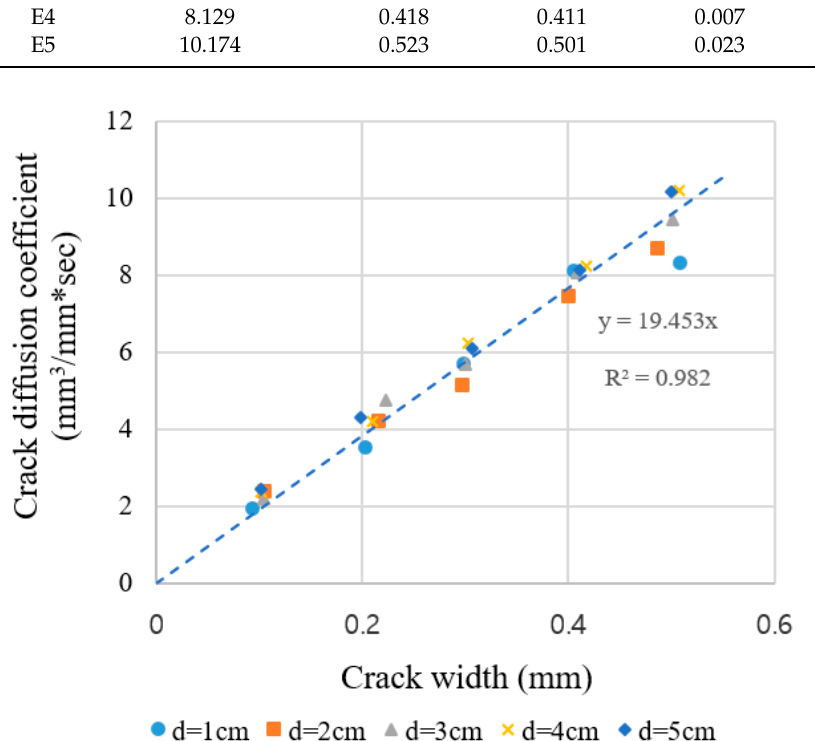
Figure 7. Crack diffusion coefficients versus crack width of the acrylic specimens. Figure 7. Crack di ff usion coe ffi cients versus crack width of the acrylic